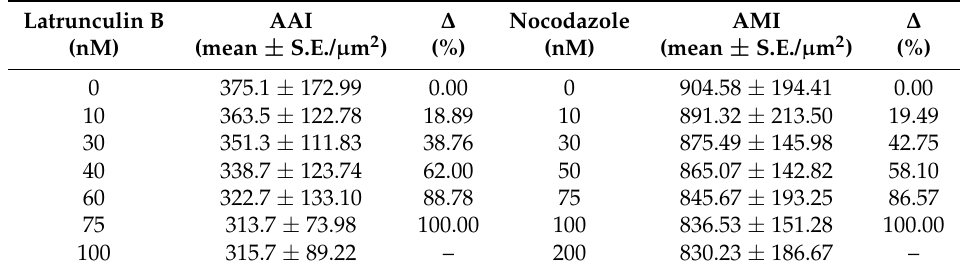
Table 1. Quantification results of average F-actin intensity (AAI), average microtubule intensity (AMI), and corresponding percentage change ( ∆ ) at different treatment